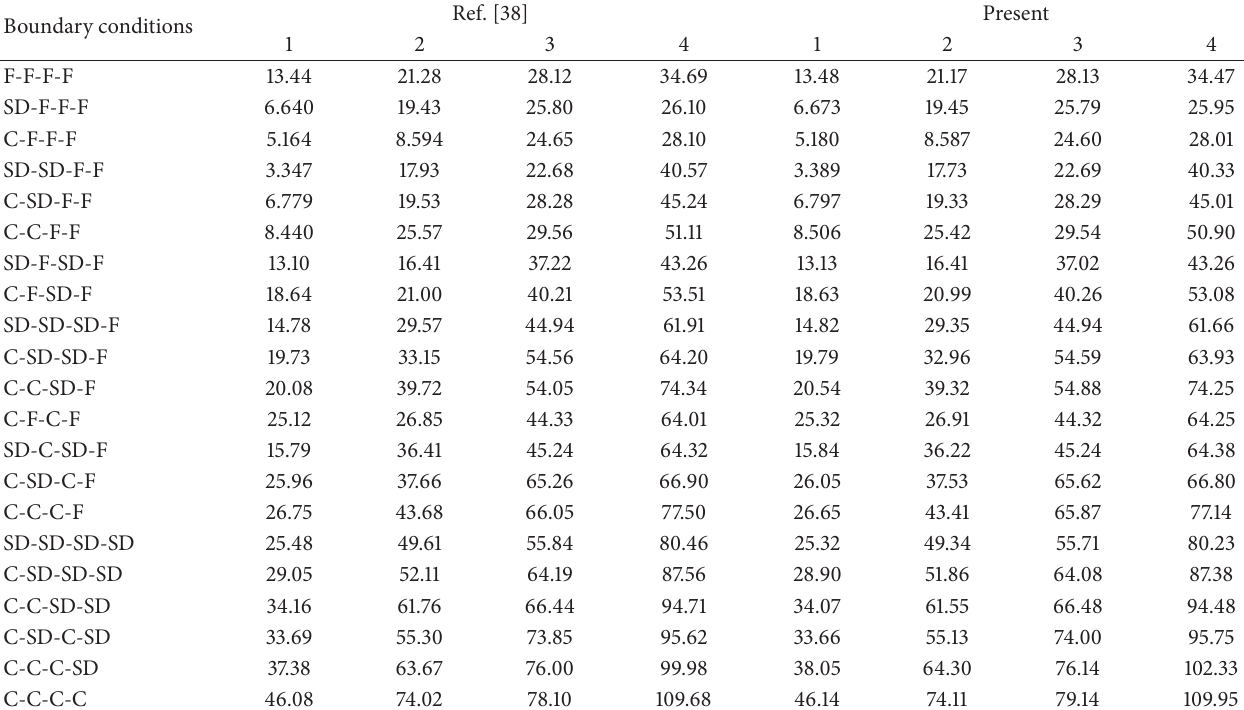
Table 2: Comparison of the first four frequency parameters Ω = 𝜔𝐿 2 √𝜌ℎ/𝐷 for an open cylindrical shell with various boundary conditions. Boundary conditions